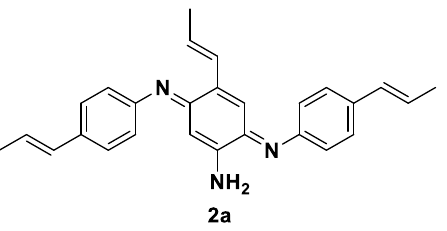
Figure 2. Hypothesized structure of the trimeric Bandrowski’s base -like product 2a formed in traces from 2 [36].